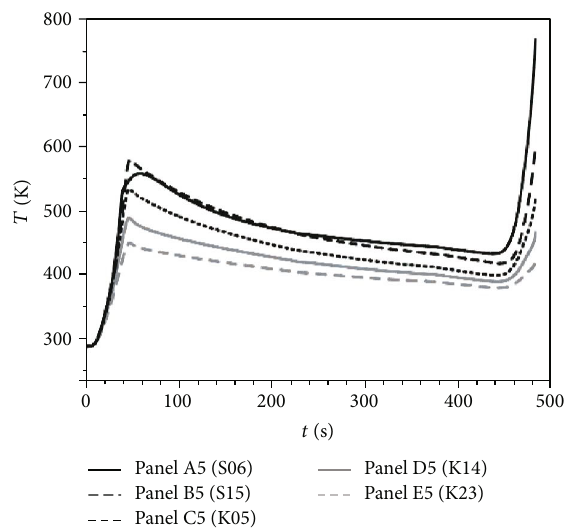
Figure 18: Measured temperatures at row